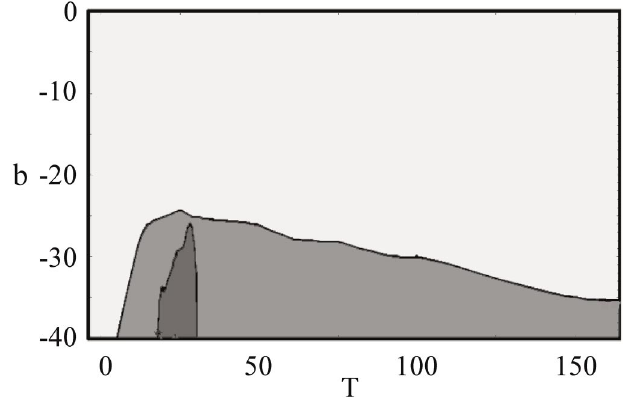
FIG. 1. Gaussian approximation with (cid:3) 0 wake. Nature of the solutions in parameter subspace f b; T g with (cid:15) gray: period-1; dark-gray: period-2 or higher; medium-gray: